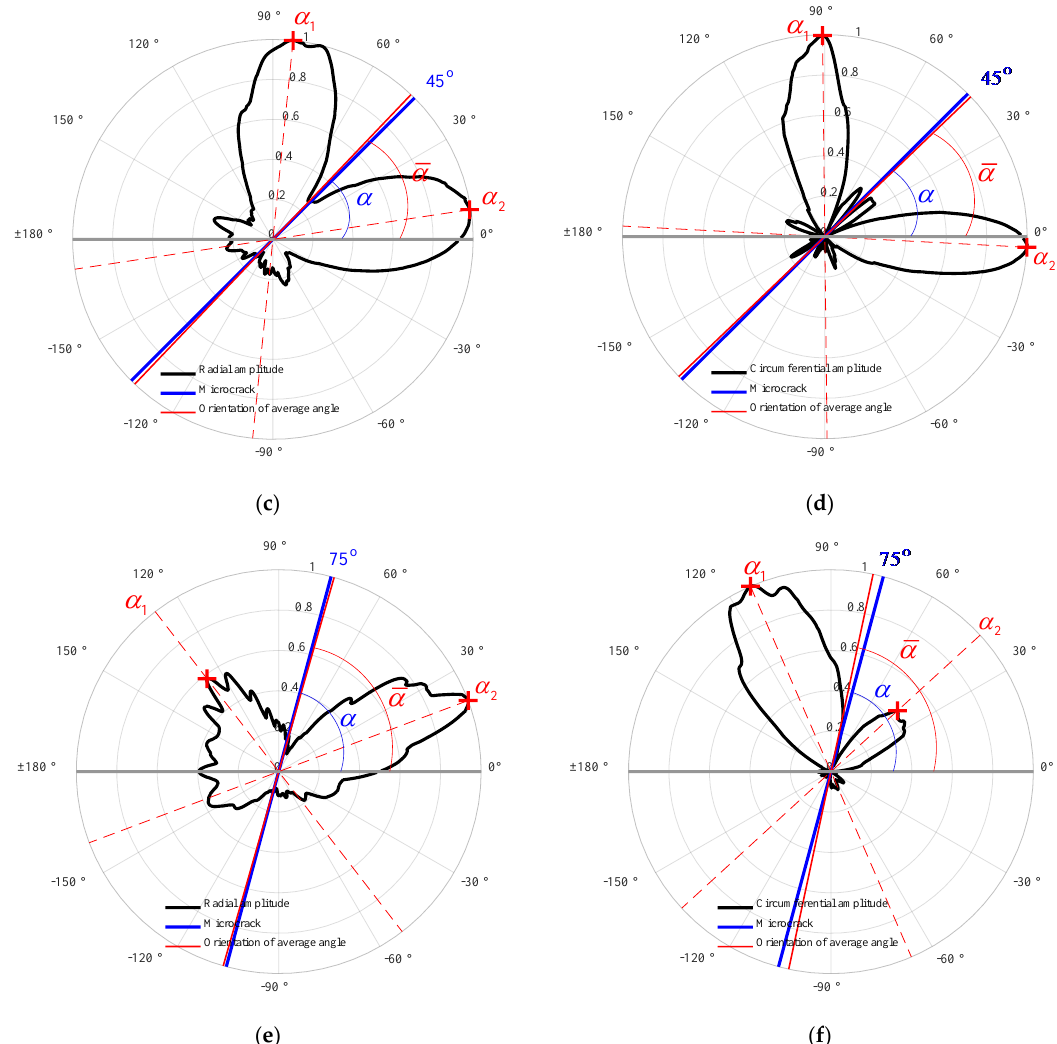
Figure 5. Normalized directivity of the radial ( a , c , e ) and circumferential ( b , d , f ) second harmonic amplitudes for several microcrack orientations.